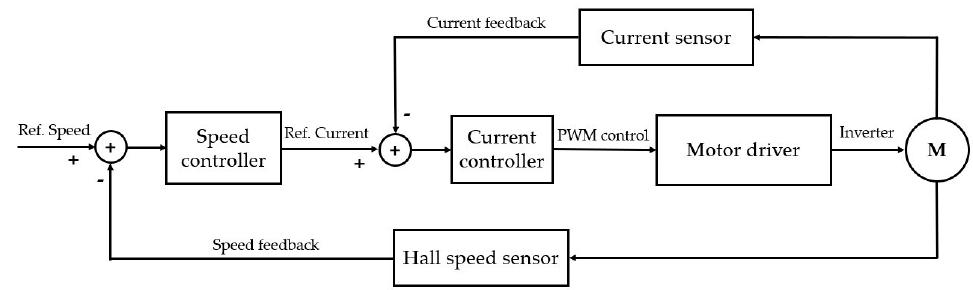
Figure 16. Block diagram of the BLDC motor control system.